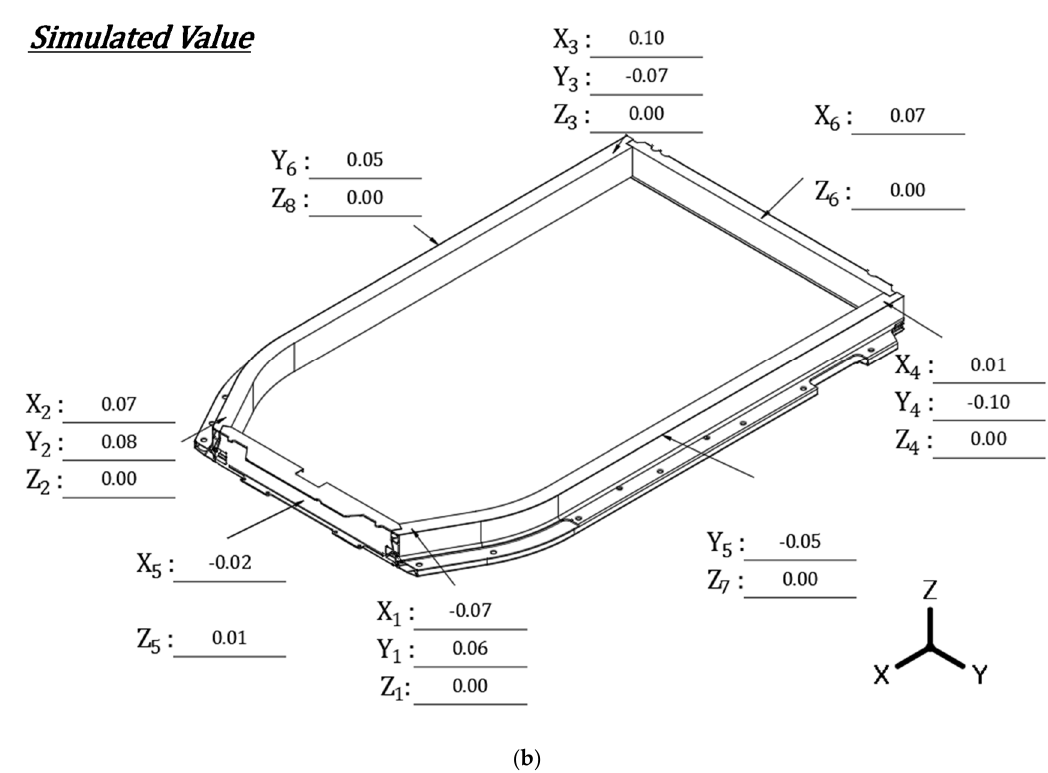
Figure 22. Comparative verification of FSW variant: ( a ) Measured values; ( b ) simulated values. Table 11. Comparison of variation between measured and experimental values [unit: mm]. Measured Value Simulated Value Mean Deviation